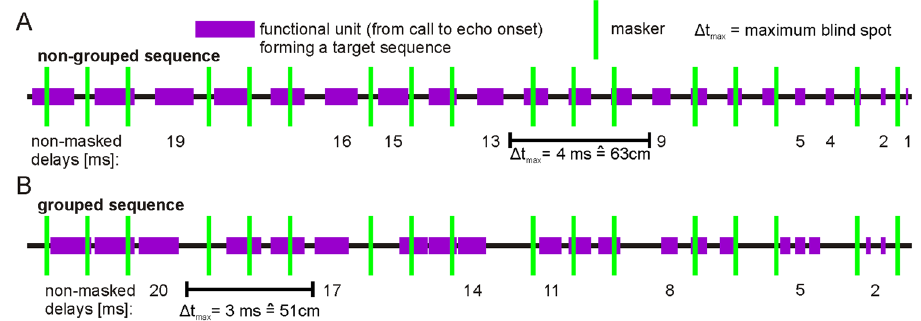
Figure 5. Grouping calls makes distance processing more robust against maskers. Two schematic echolocation/ target sequences are presented in violet. Each violet bar represents a functional unit spanning the time from call to echo onset. Both sequences contain 21 functional units, but they have different time structures. In ( A ) the calls are equally distributed (non-grouped sequence) and the encoded echo delays range from 21 to 1 ms in 1 ms steps. In ( B ) the calls are grouped into triplets where each functional unit of a triplet encodes a similar delay ( < ± 1 ms). The delay information encoded by a functional unit gets masked if a masker occurs during the functional unit. Non-masked delays are indicated below each sequence. Δ t max represents the maximum blind spot that the bat would perceive in case of the masker